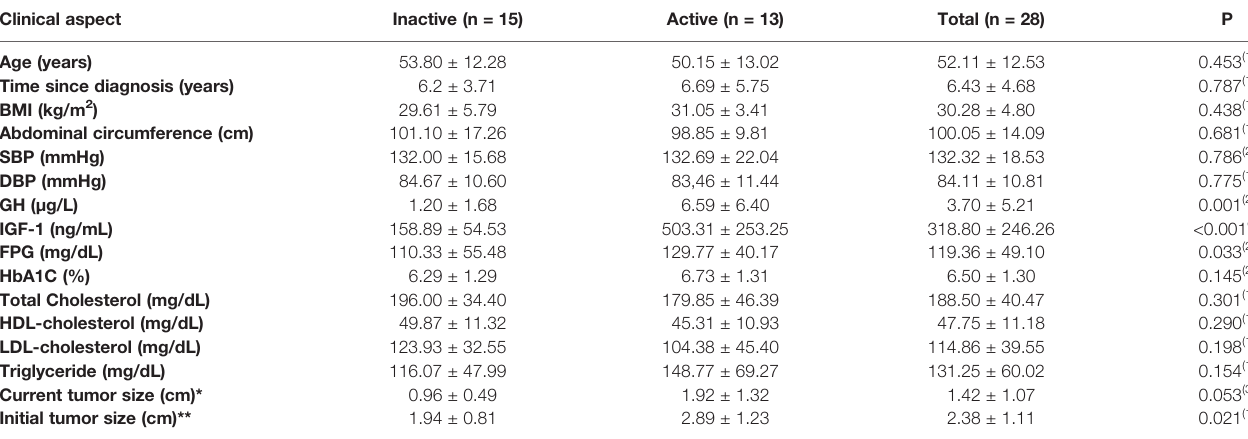
TABLE 1 | General characteristics of the study patients (Agamenon Magalhães Hospital,